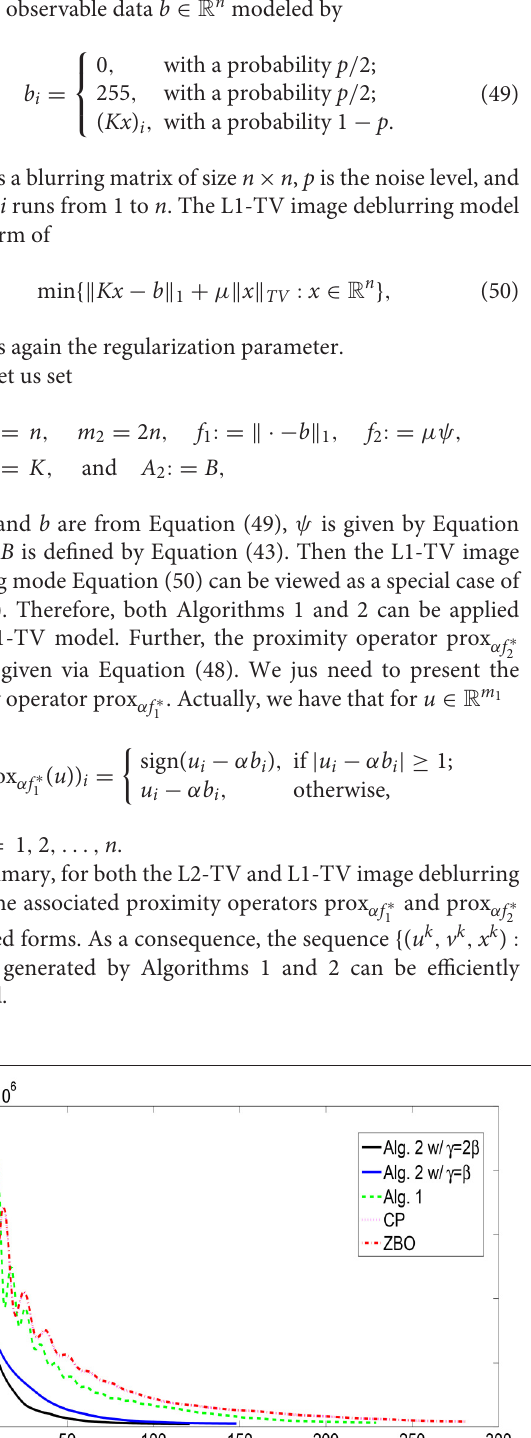
Frontiers in Applied Mathematics and Statistics |